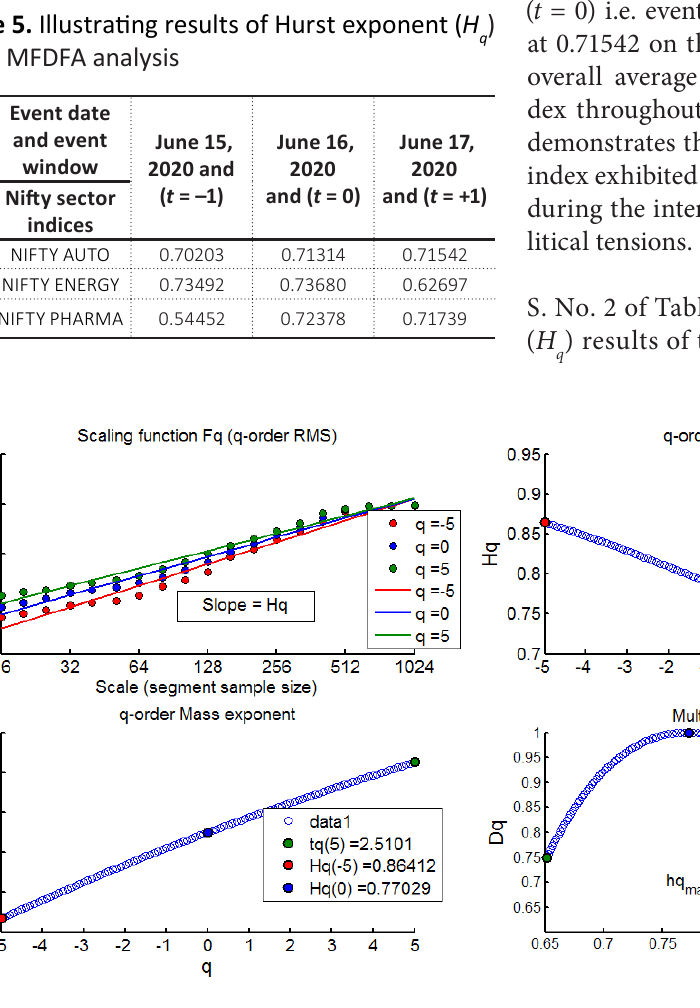
(5) of Nifty Auto index on June 15, 2020, i.e., ( t = Figure 1. The H q